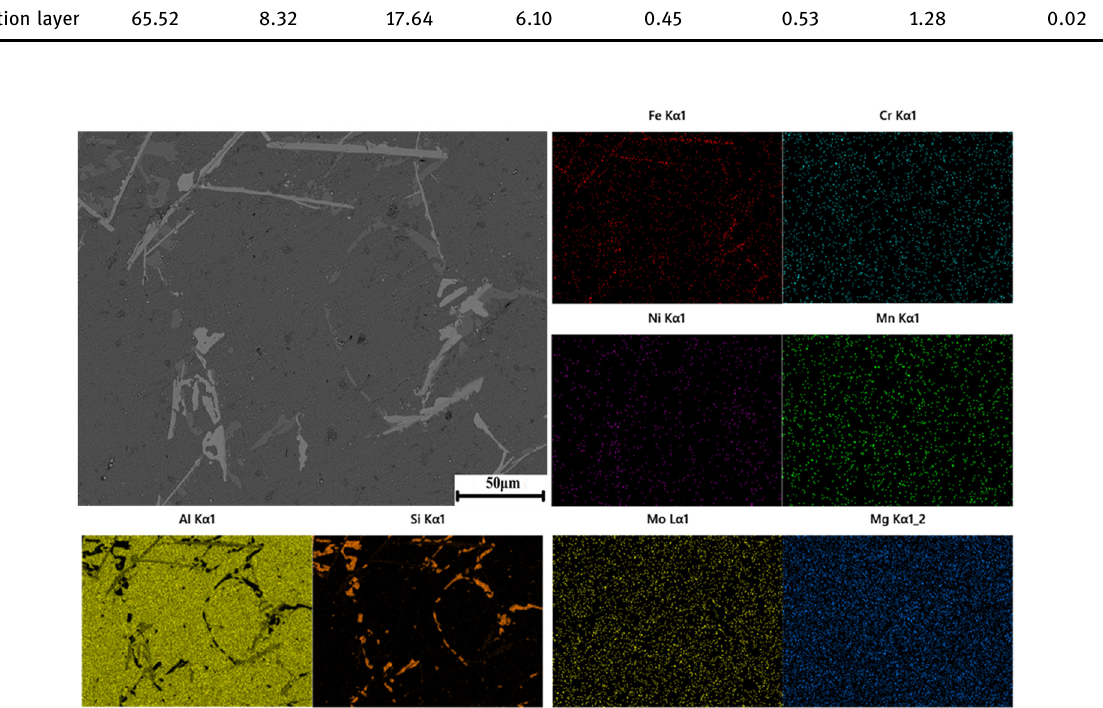
Figure 5: The phases and the distribution of alloying elements in the matrix.